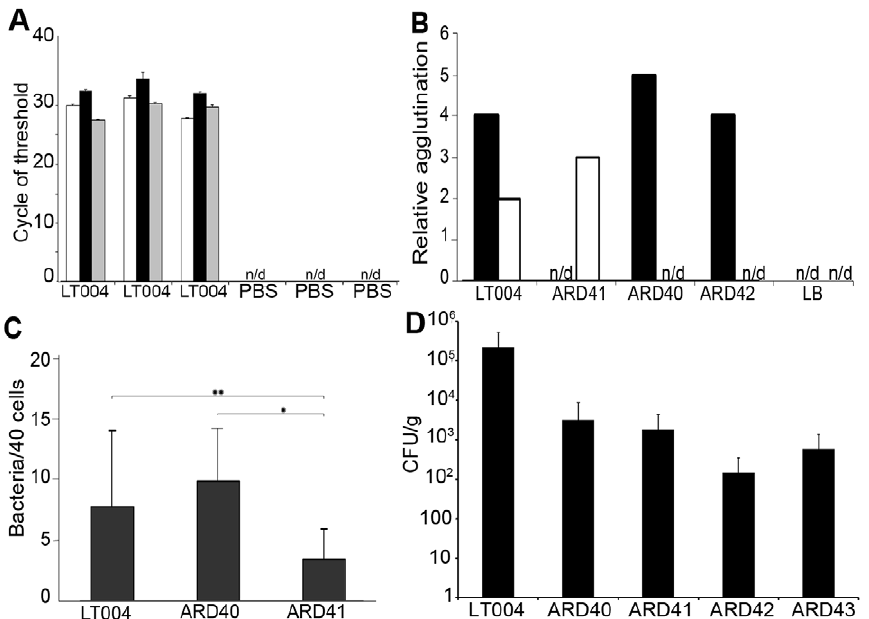
Figure 2. Expression, binding and infection characteristics of P and Type 1 isogenic strains. ( A ) qRT-PCR analysis of micro-dissected tissues 8 h after infusion with LT004 or PBS. Bars show cycle of threshold for detection of gfp + (white), papA_2 (black) and fimA (grey) transcript. n/d = not detectable. Each group is from an individual animal ( B ) Relative agglutination of human O type red blood cells, indicating PapG mediated agglutination (black) and yeast cell agglutination in the absence of mannose, indicating FimH mediated agglutination (white) for indicated strains using LB medium as control. ( C ) Bacterialadhesion (counted per40 cells) to A498 humanrenal epithelialcells. * P=0.001, ** P=0.045 Error bars in (a,c) = standarddeviation. ( D ) Number of bacteria in the kidney, shown by CFU/g tissue, following a 4-day ascending infection. doi:10.1371/journal.ppat.1001298.g002 Table 1. Bacterial strains and oligonucleotides used in this study.